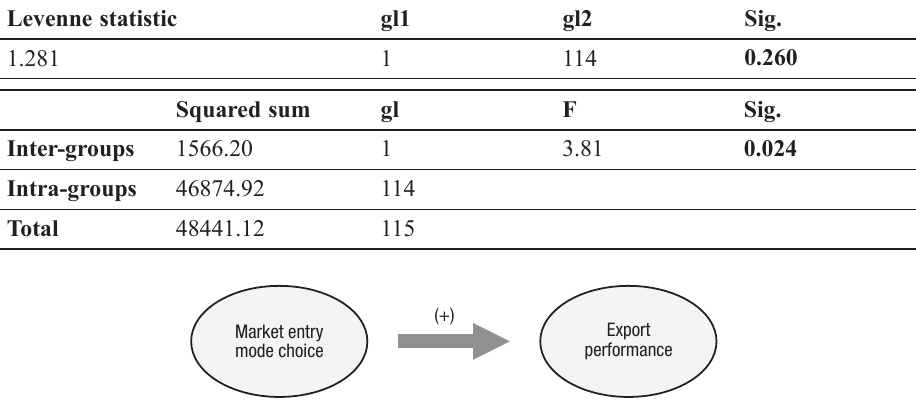
Fig. 1. Relationship market entry mode choice – export